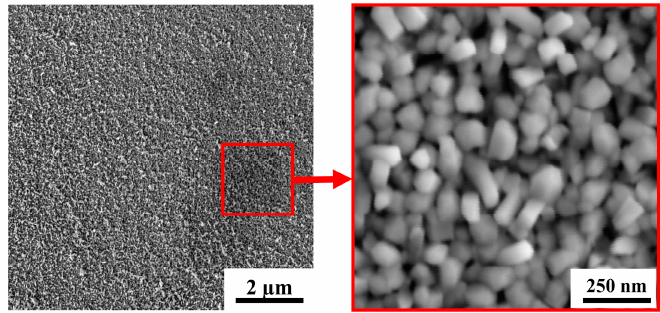
Figure 4. SEM images with two magnifications for a WO 3 film obtained on an FTO substrate by RPLD at a dry air pressure of 40 Pa.